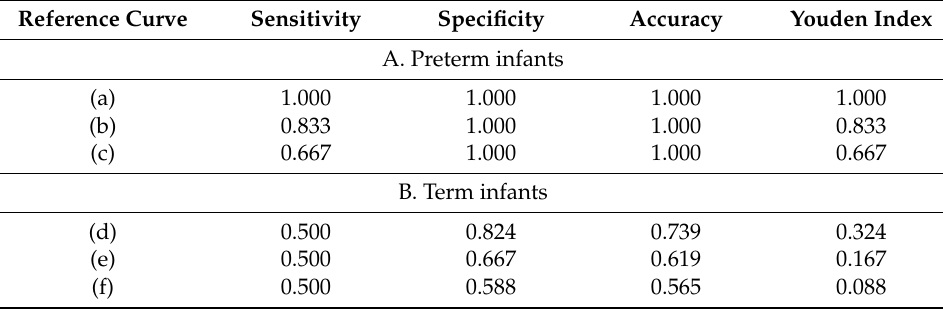
Table 5. Comparisons among serum PCT reference curves.